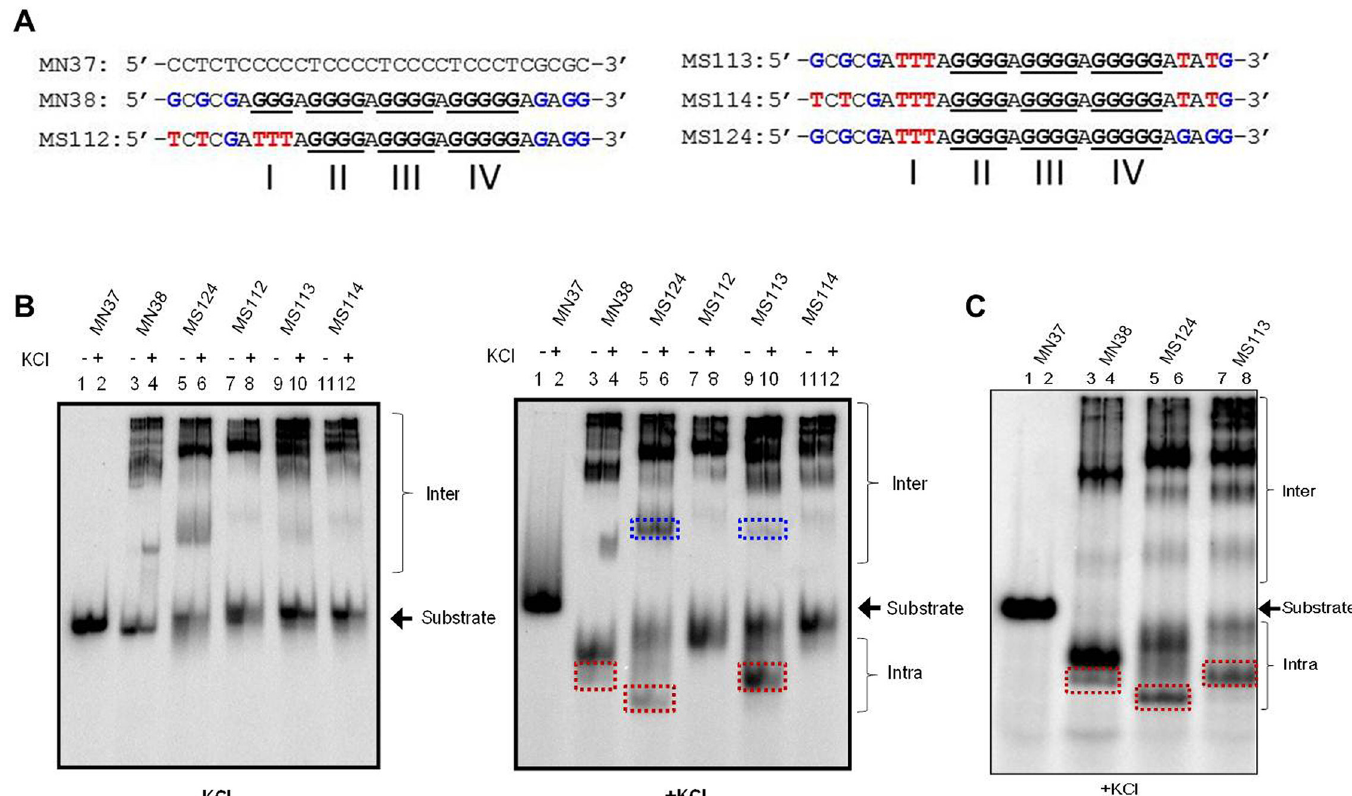
Fig 1. Evaluation of effect of GNG motifs in G-quadruplex structure formation at HOX11 translocation breakpoint region. (A) The oligomeric DNA sequence spanning region I of chromosomal translocation breakpoint region from HOX11 gene. A G-rich strand (MN38), its mutants (MS112, MS113, MS114, MS124) and complementary C rich strand (MN37) are designed based on sequence of HOX11 breakpoint region and used for the study. The mutations were introduced such that the first G stretch is altered to thymines (indicated in red) and keeping that as the backbone, the first GNG motif (indicated in blue) or the second GNG motif (indicated in blue) or both are mutated (mutations shown in red). (B) Radiolabeled oligomeric DNA with G-rich, C- rich or mutant DNA sequence were incubated in the presence (+) or absence (-) of KCl (100 mM) and resolved in the absence (left panel) or presence (right panel) of KCl (100 mM) in the gel and running buffer. (C) Radiolabeled oligomeric DNA with G-rich, C-rich or mutant DNA sequence were heat denatured, gradually cooled and resolved in the presence of KCl in the gel and running buffer. For each oligonucleotide duplicate reactions are loaded in adjacent lanes. The substrate, intramolecular (Intra), and intermolecular (Inter) quadruplex structures are indicated. The red boxed intra indicate intramolecular G- quadruplex species involving GNG motifs. The blue coloured box indicate bimolecular G-quadruplex.